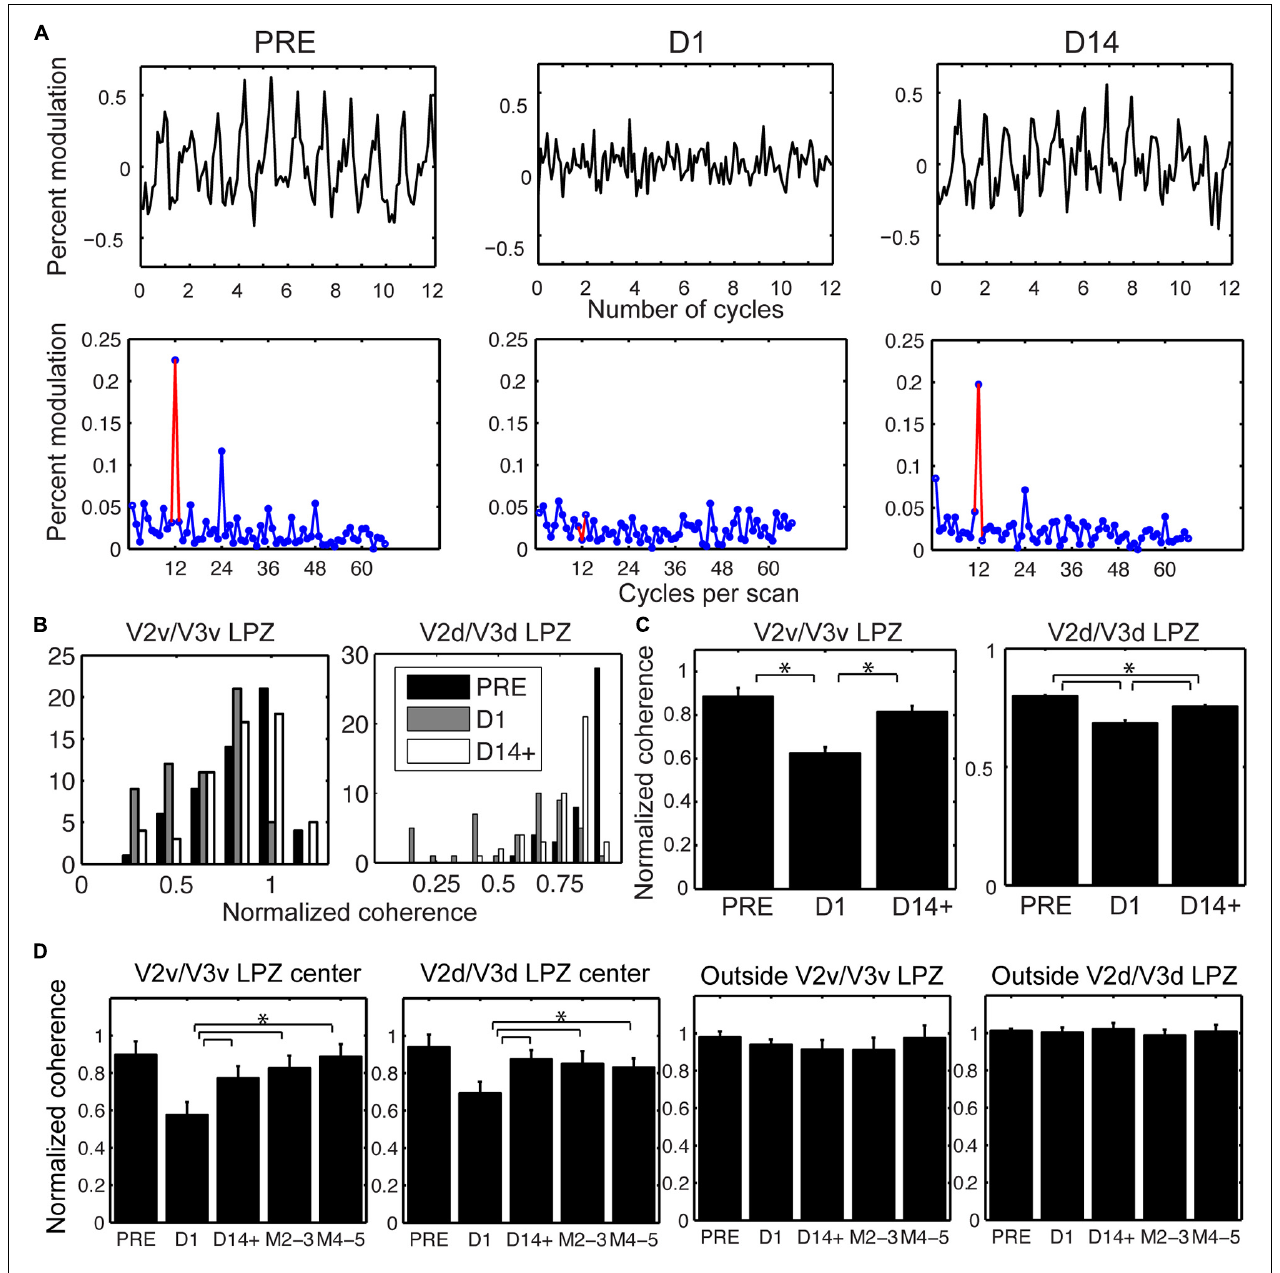
FIGURE 4 | Longitudinal changes in the strength of visual modulation inside the V2/V3 LPZ. (A) Top row: Percent BOLD signal modulation as a function of stimulus cycle from voxels inside the V2v/V3v LPZ of M1 with low coherence ( < 2 standard deviations above noise level on day 1), plotted pre-lesion (PRE) and on days 1 (D1) and 14 (D14) post-lesion. Bottom row: Average signal amplitude as a function of temporal stimulation frequency (12 cycles per scan, indicated by the red color). Note that the strength of the visual modulation recovers over time. (B) Distribution of normalized coherence values (see section “Materials and Methods”) for all functional voxels inside the V2v/V3v and V2d/V3d LPZs pre-lesion and at D1 and D14+ post-lesion histogrammed across all monkeys. Note that the number of voxels with low coherence inside the V2/V3 LPZ increases on the day of the lesion, then appears to substantially recover by D14+. (C) Mean normalized coherence across all functional voxels inside the V2v/V3v and V2d/V3d LPZ pre-lesion, as well as D1 and D14+ following the lesion, plotted across all monkeys. One–way ANOVA shows a significant effect for both LPZ’s over time ( F = 76.48, p < 10 − 8 for V2v/V3v LPZ and F = 11.45, p < 10 − 5 for V2d/V3d LPZ). Tukey post hoc pairwise comparisons show that the strength of visual modulation dropped significantly on Day 1 compared to pre-lesion values, and then rose again significantly from Day 1 to D14+ post-lesion in both the ventral and the dorsal LPZ. Error bars represent s.e.m. ∗ p < 0.05. (D) Mean normalized coherence across the voxels inside the V2v/V3v or V2d/V3d LPZ that were either within 2 standard deviations of noise level (LPZ center) or greater (Outside) on day 1 (lesion day; see section “Materials and Methods”) is plotted as a function of time across animals. Error bars represent s.e.m. ∗ p < 0.05. Note that the mean coherence drops on the day of the lesion (D1) and then increases over time following the lesion (M2-3 and M4-5 refer to months after the lesion). This agrees with (B,C) , which represent the aggregate response across all